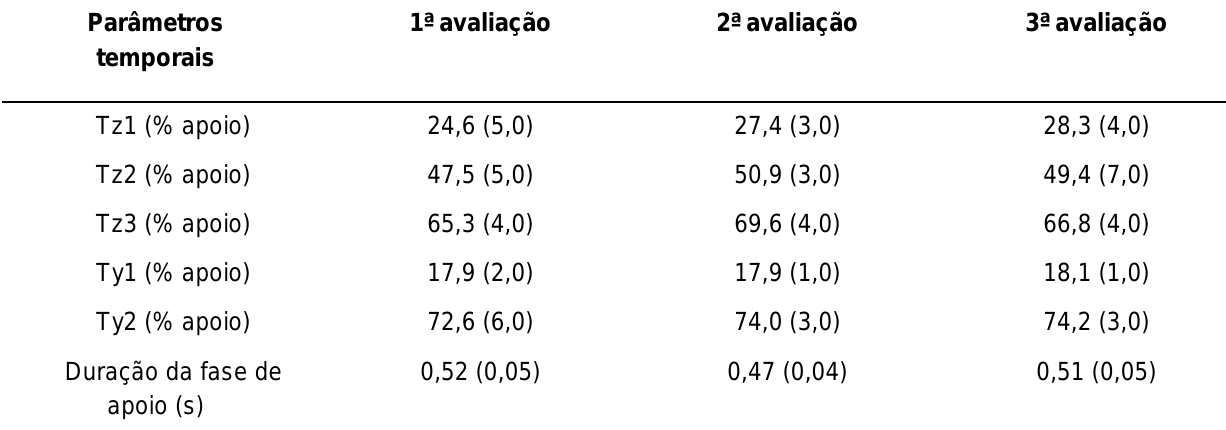
Tabela 3. Valores médios (desvios-padrão) dos parâmetros temporais, normalizados pela porcentagem da fase de